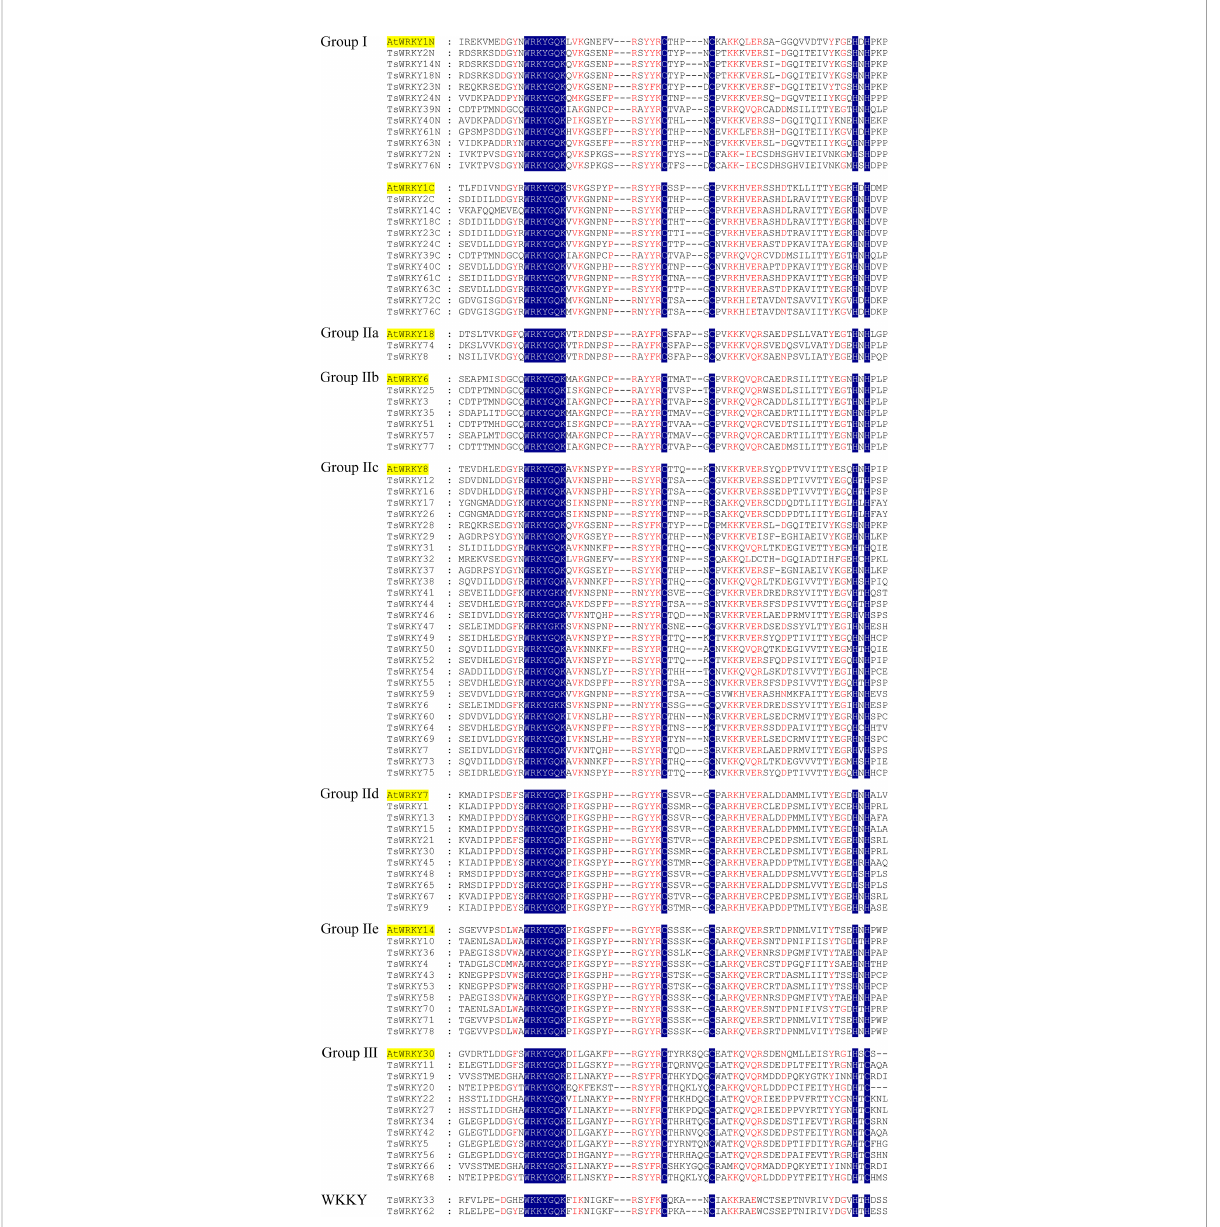
FIGURE 1 Multiple TsWRKY domain amino acid sequences were aligned with reference to AtWRKY. The letters “ N ” and “ C ” represent WRKY domains, which are found at the N and C terminal ends of amino acid sequences,